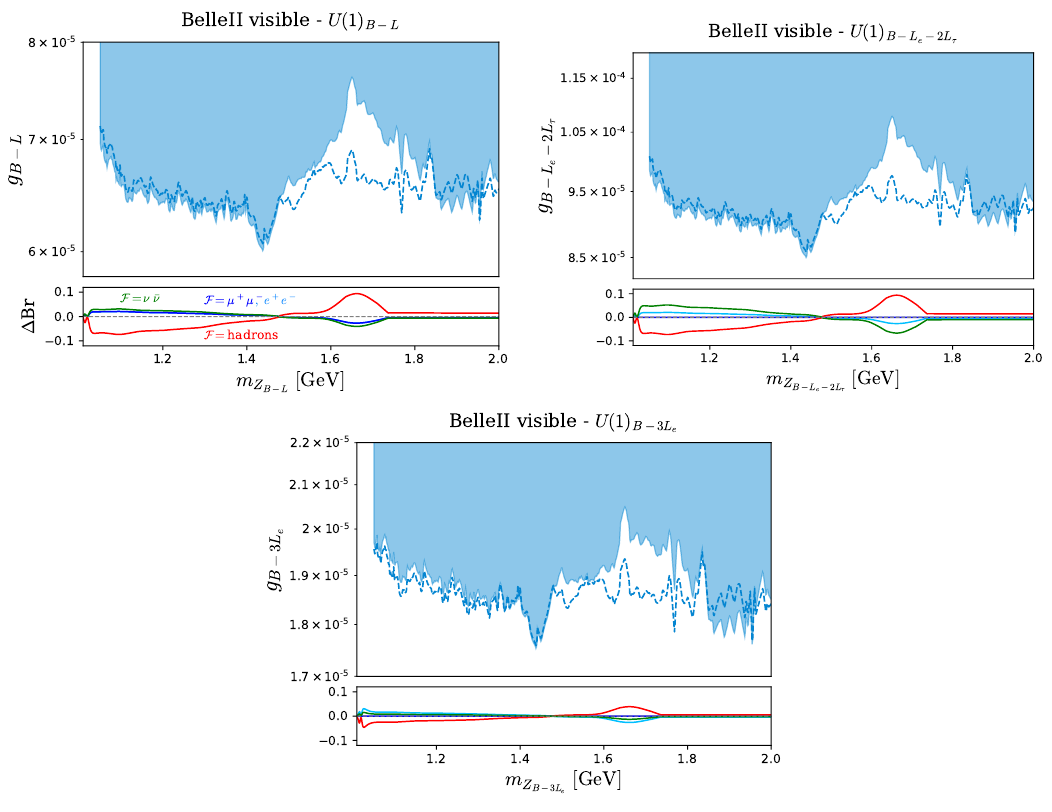
Figure 14 . Similar to figure 13 but for Belle II visible searches and for the following models: B − L (top left panel), B − L e − 2 L τ (top right panel) and B − 3 L e (bottom panel). In solid light blue (dashed line) we show our ( DarkCast ) results.